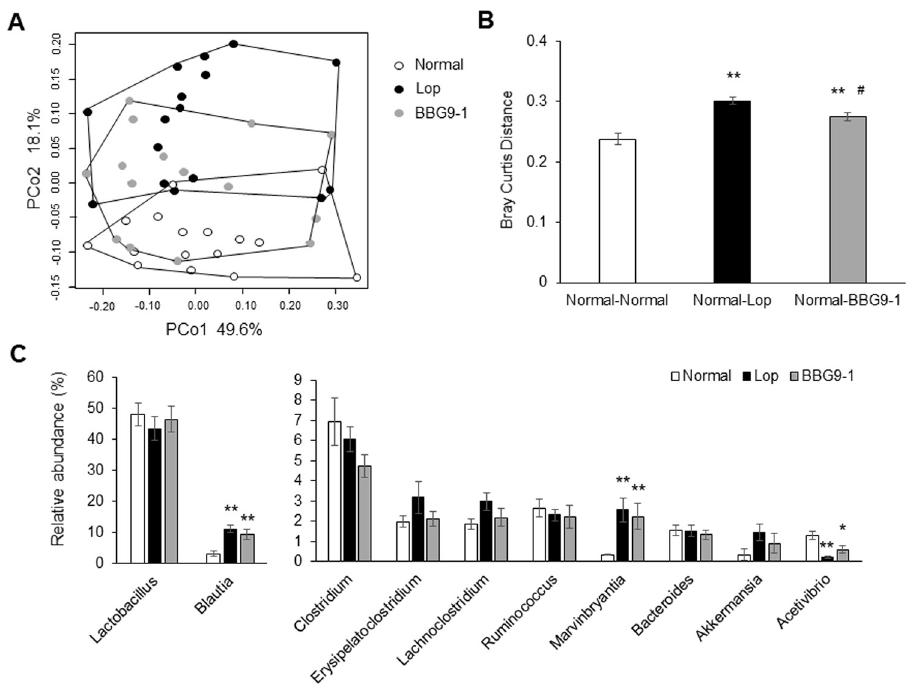
Fig 4. Effect of BBG9-1 on the structure of fecal microbiota in loperamide-induced constipation rats. (A) PCoA showed the clustered communities of fecal microbiota based on the Bray-Curtis dissimilarity between samples. (B) The calculated distance of Normal, Lop, and BBG9-1 groups in Bray-Curtis distance analysis. (C) The relative abundance of each bacterial genus was analyzed using 5000 next-generation sequencing reads of bacterial 16S rDNA. Values are means ± SE of 15 or 16 animals. � and �� , p < 0.05 and 0.01 vs. Normal; #, p < 0.05 vs.